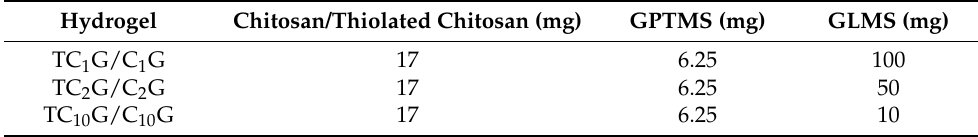
Table 1. The amounts of chitosan/thiolated chitosan, GPTMS and GLMS used in a 1 mL hydrogel.